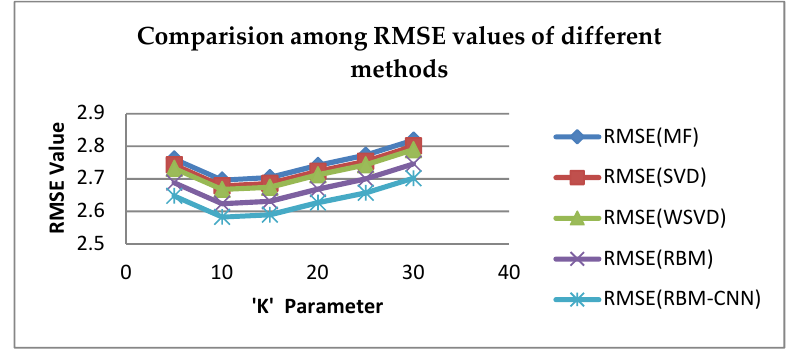
Figure 10. Comparison among K and RMSE of different methods.